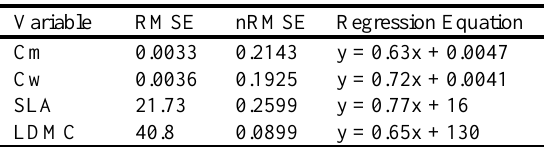
Table 4. Root mean square error (RMSE), normalized RMSE (nRMSE) and regression equations between observed and estimated values of C m , C w , SLA and LDMC from inversion of the PROSPECT model.